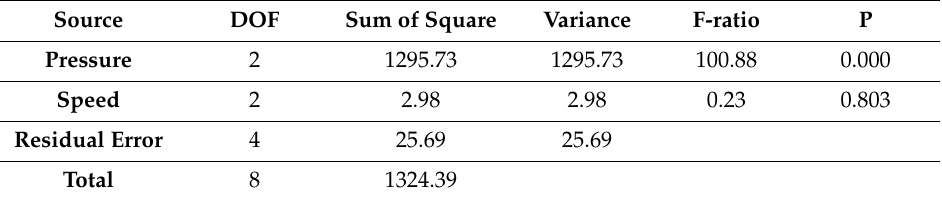
Table 4. Analysis of variance for means.